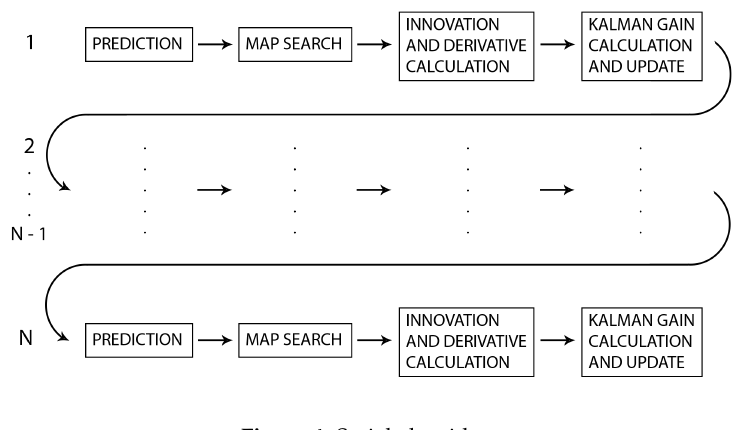
Figure 4. Serial algorithm.